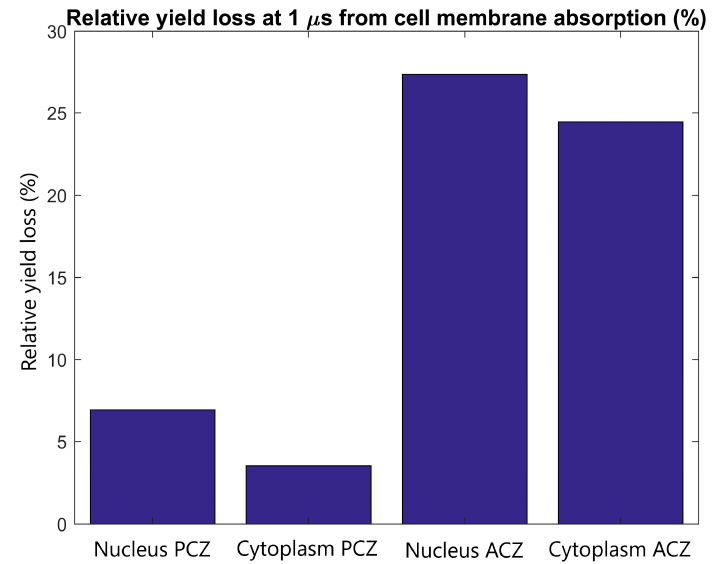
Figure 7. The relative radiolysis yield loss at 1 µs in the nucleus and cytoplasm of the adjacent and primary cell from electrons emitted by GNPs within the primary cell with full absorption at the cell membrane compared to the yield for without absorption. Results are shown for tightly packed cells separated parallel to the proton beam (along the Z axis).